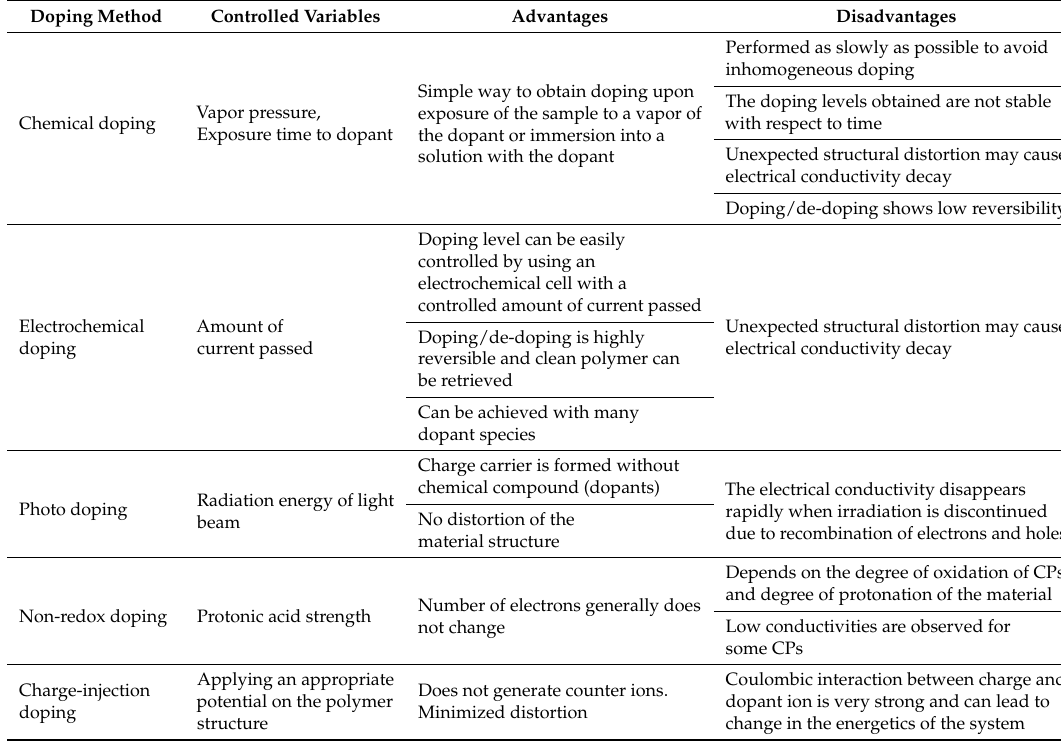
Table 3. Different methods used for doping